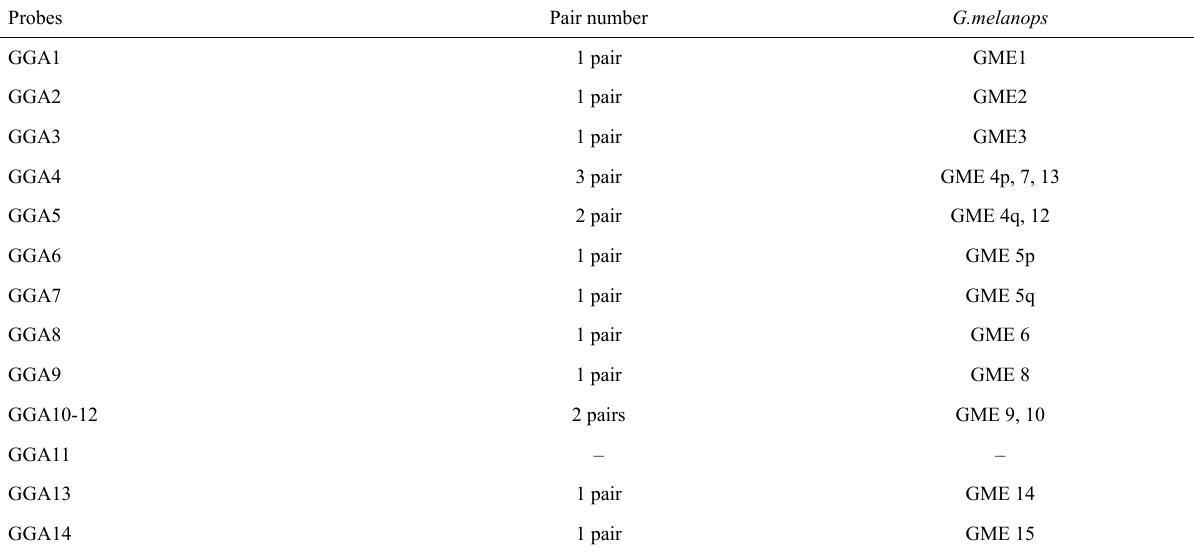
Table 1 – Correspondence between Gallus gallus (GGA) and Gallinula melanops (GME) chromosomes.